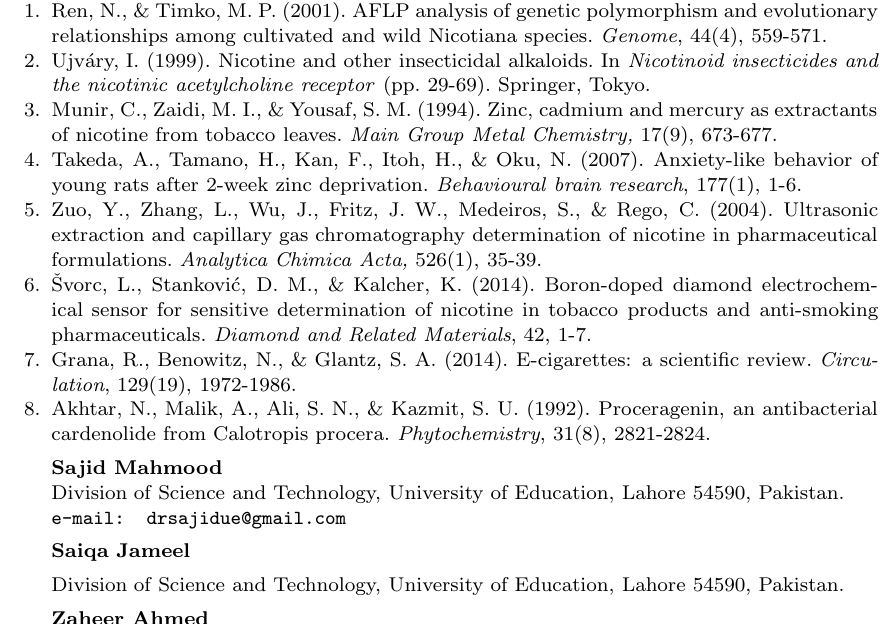
Conc. µ g / 100 µ L 100